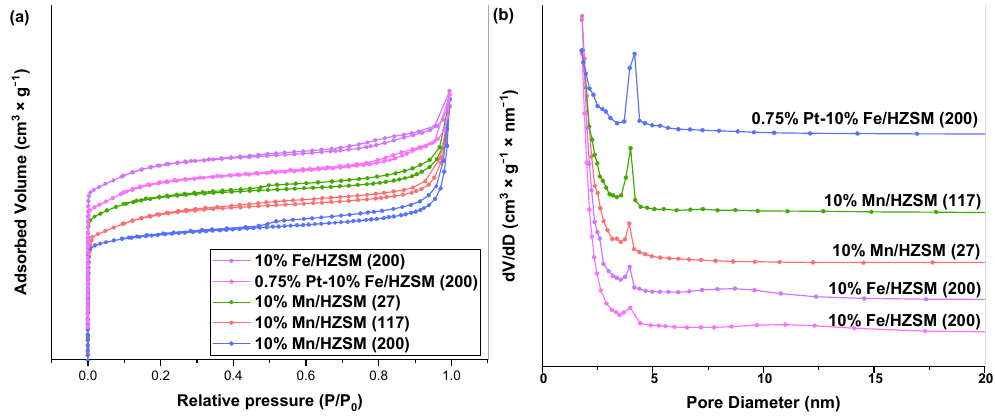
Figure 2. N 2 adsorption–desorption isotherms ( a ) and pore size distribution ( b ) of the catalysts. Table 1. Textural properties of the catalysts.